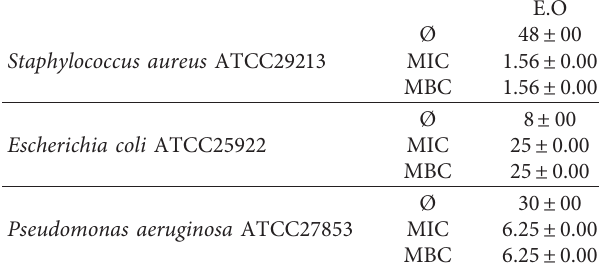
Table 2: Antibacterial activity in the essential oil of T. articulata leaves